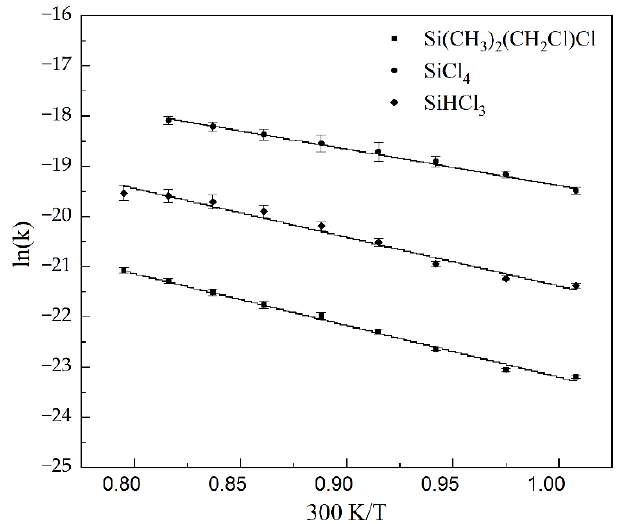
Figure 3. Dependence of the logarithm of k vs. 300 K/T for investigated molecules.